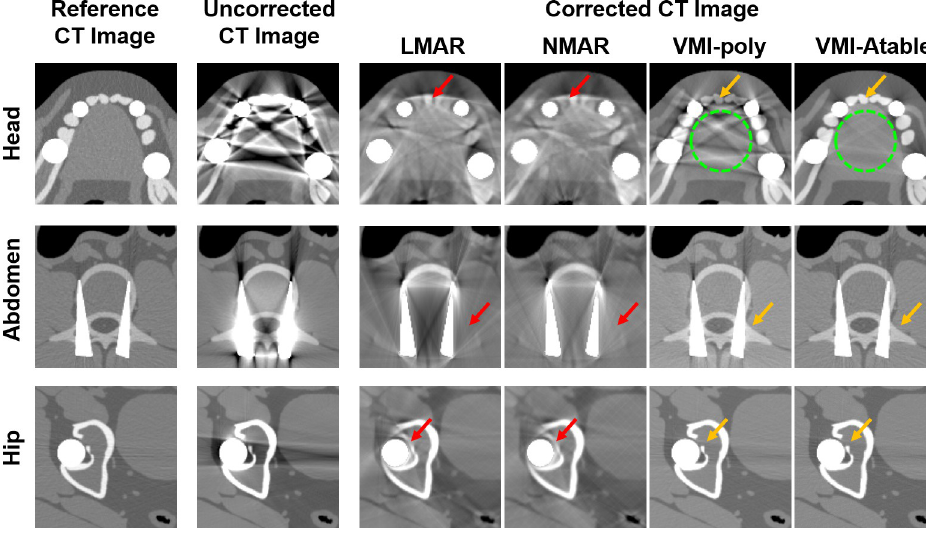
Fig 9. Enlarged images of the three ROIs in Fig 8. Each row corresponds to a different part of the human body. The columns represent the reference CT image; uncorrected CT image with metal artifacts; and corrected CT images using LMAR, NMAR and projection-based VMI algorithms (VMI-poly and VMI-Atable) at 100 keV. Window width and level of the image display are 1,000 HU and 0 HU, respectively.